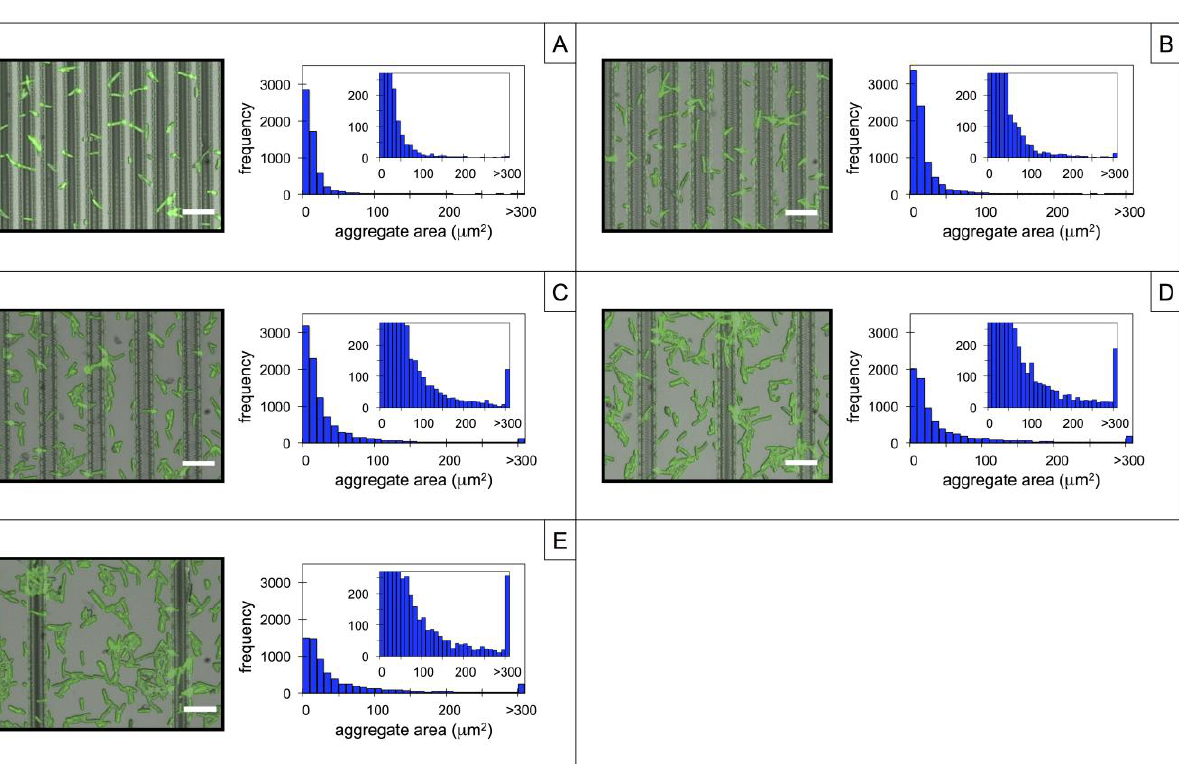
Figure 2. Composite brightfield-fluorescence images (100×) and corresponding histogram plots of surfaces containing PGMA- b -PVDMA films patterned as line arrays with a pitch of ( A ) 7 µm, ( B ) 10 µm, ( C ) 15 µm, ( D ) 25 µm, and ( E ) 45 µm after WGA functionalization and microbe incubation. Aggregate sizes were measured over a 2.0 mm 2 area for each line array. Histogram insets are zoomed-in plots showing the frequencies of the larger aggregates. Scale bar = 10 µm in all